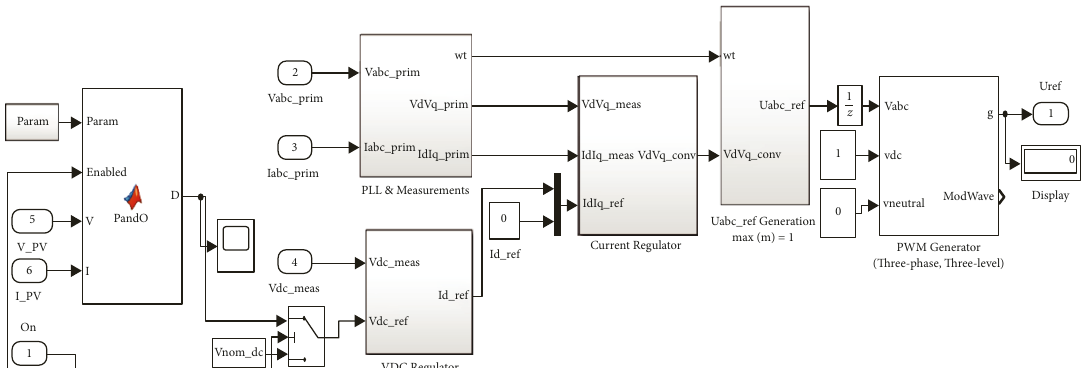
Figure 9: The PO proposed